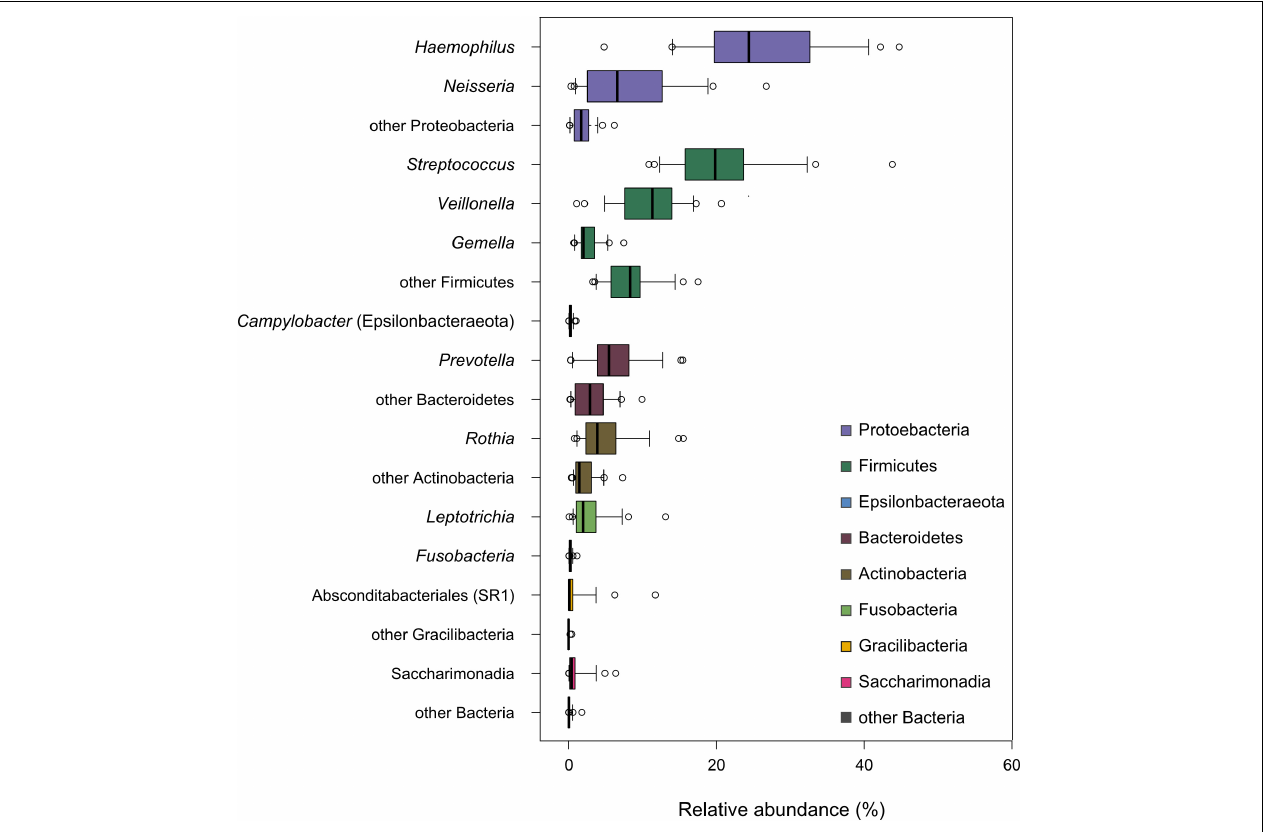
FIGURE 5 | Tongue dorsum microbiome composition across all study participants. The cumulative relative abundance per individual of amplicon sequence variants (ASVs) classified as select, dominant bacterial genera is shown in the box plots. The phylum-level taxonomic classification of these genera is indicated by the box